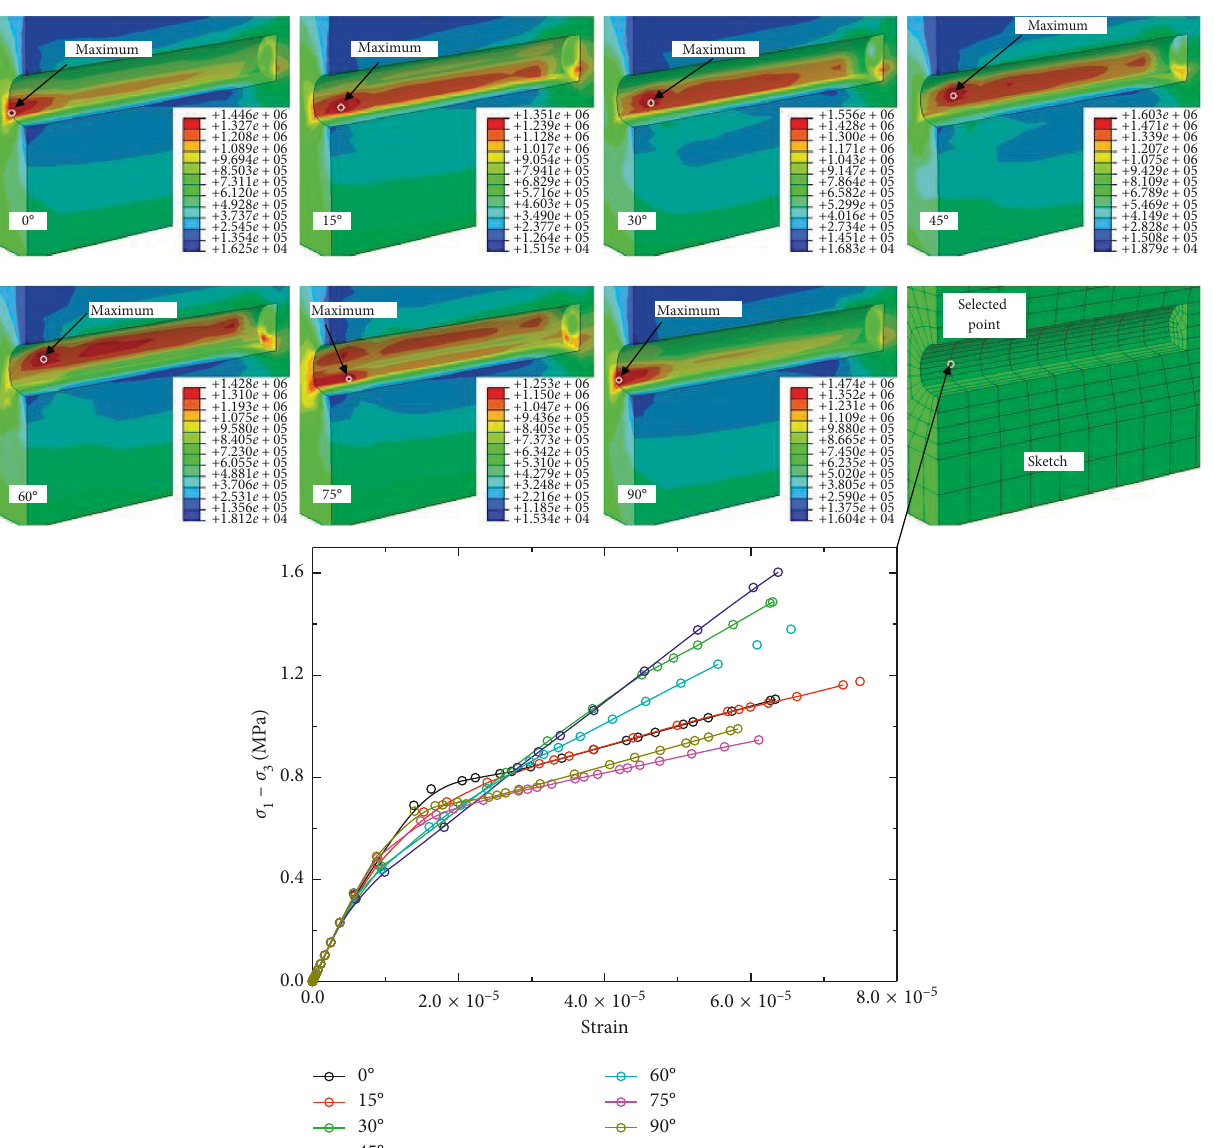
Figure 20: Stress ( σ